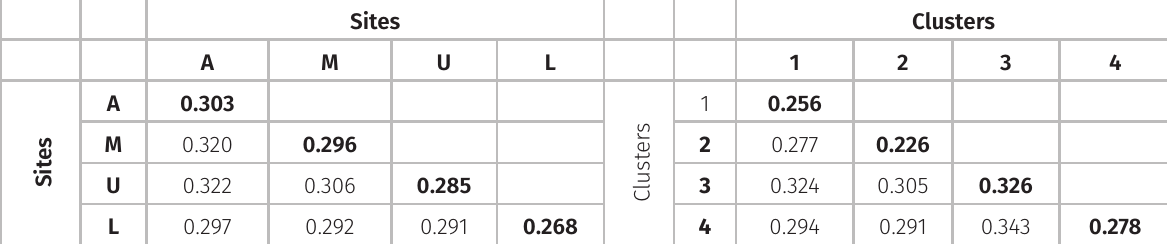
Table III. Mean genetic distances (complementary of Dice index) calculated within and among plantation sites (“Sites”), indicated by the single letter code (A, M, U, L; see Table I), and mean values estimated within and among DAPC genetic clusters (“Clusters”). Values estimated within groups are in bold type; distances among groups are in plain